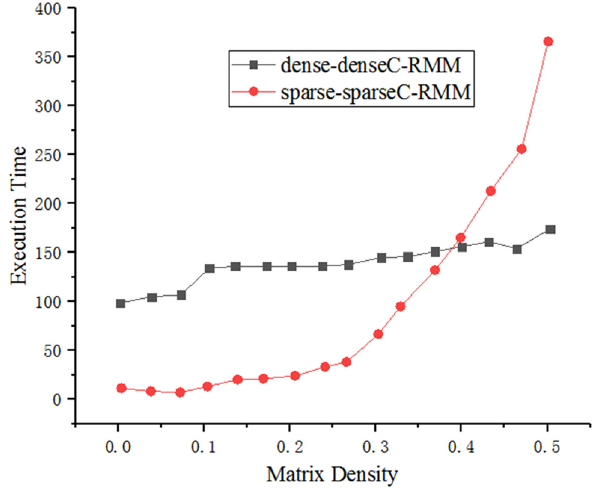
Figure 3: The performance of distributed sparse - sparse matrix multiplication varies with matrix